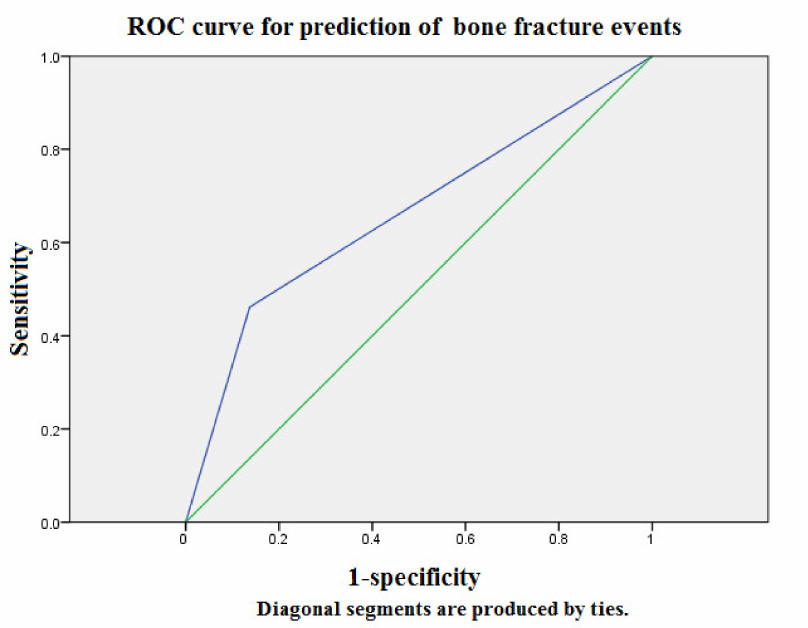
Figure 2. The ROC analysis of adiponectin concentration for prediction of BF events showed accept- able discriminatory power in the whole study population over 30 months of follow-up. The AUC provided by adiponectin tertiles for all-cause mortality was 0.66 (95% CI = 0.49 to 0.84). Source of the curve: green line = adiponectin concentrations; blue line = reference. AUC = area under curve; ROC = receiver operating